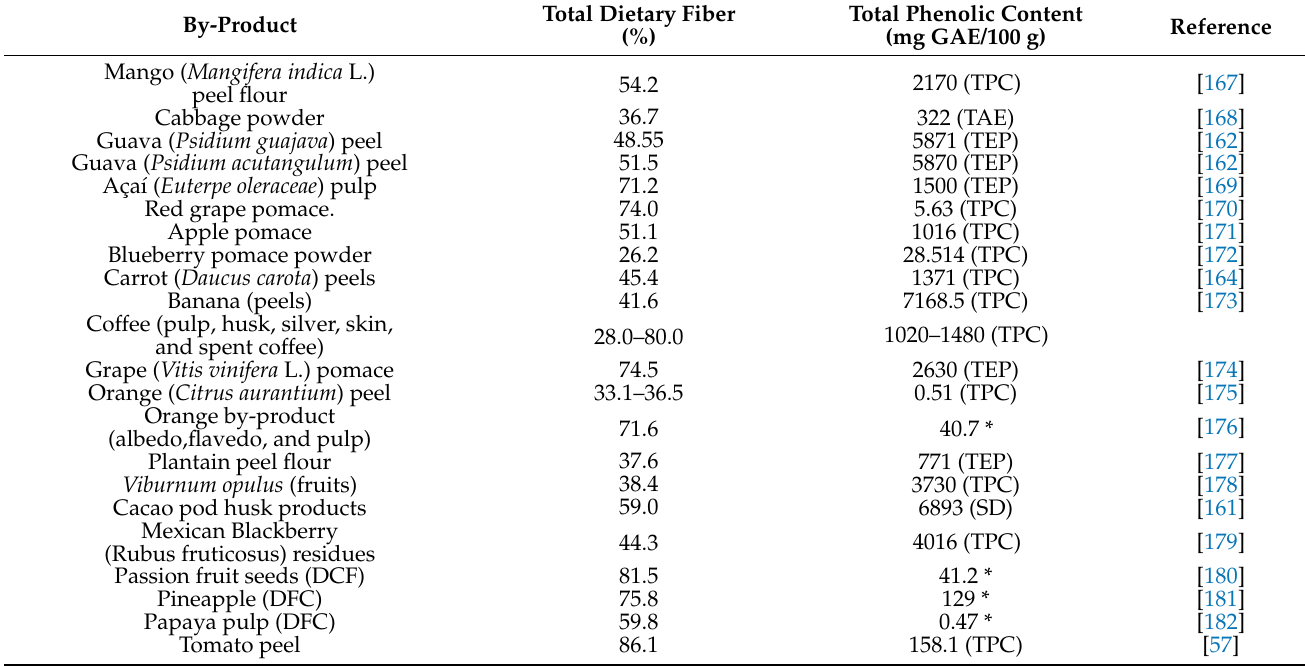
Table 1. Examples of polyphenol-dietary fibers from fruit and vegetable by-products. Adapted from